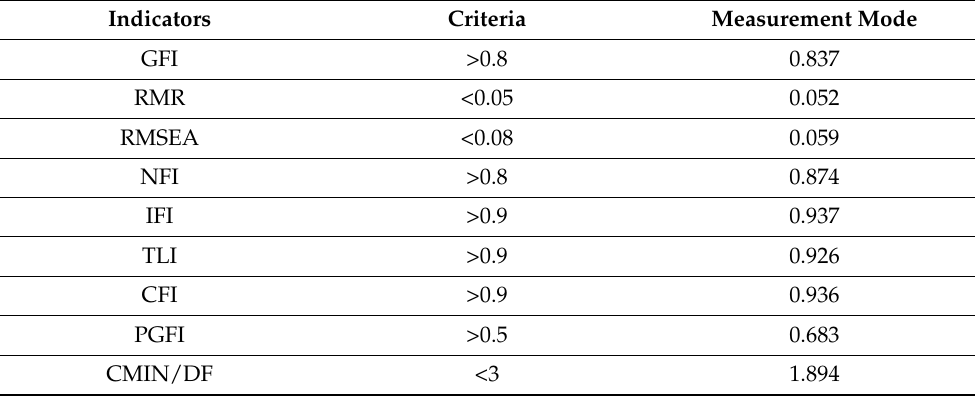
Table 5. Model fit